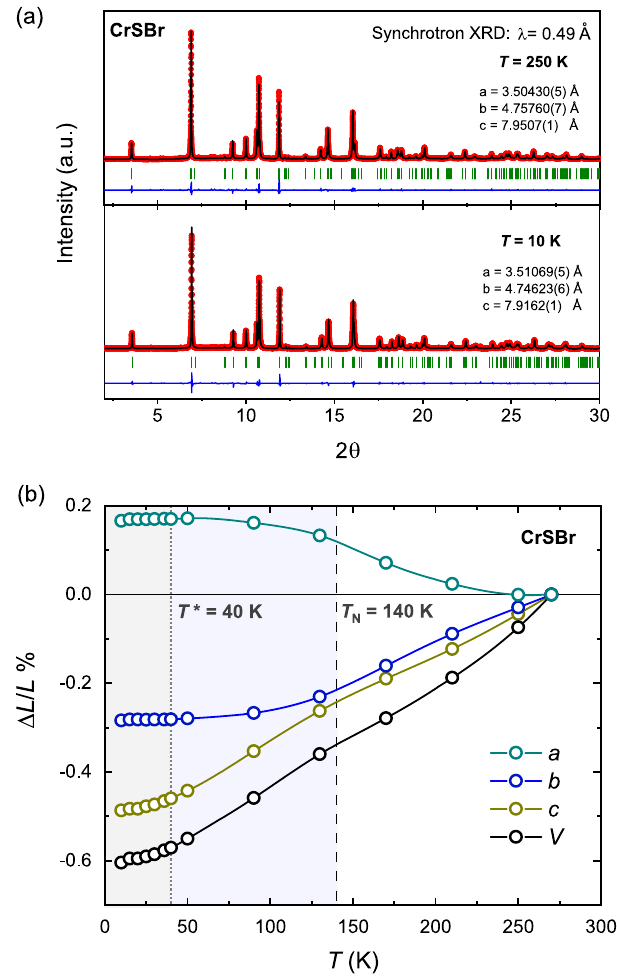
Fig. 5 | Temperature-dependent structural data of CrSBr. a The synchrotron X-ray diffraction (XRD) data of CrSBr measured with a wavelength of λ =0.49 Å at T =250K (upper panel) and 10K (lower panel), with the respective Rietveld re fi nements in the space group Pmnm . Red dots and black line correspond to the observed and calculated intensities, the blue line is the difference plot and green ticks show the Bragg re fl ections. b Normalized unit cell parameters a , b , and c , as well as the unit cell volume V in a temperature range between T =10K and 270K. Themagneticallyorderedtemperatureregionsarehighlightedbyblue( T < T N )and gray ( T < T *)